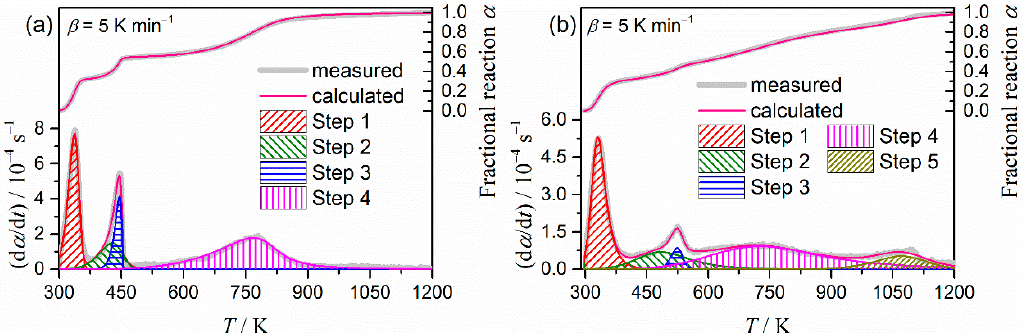
Figure 7. Typical results of KDA for the thermal decomposition of the purified clay minerals: ( a ) Palygorskite and ( b ) sepiolite.